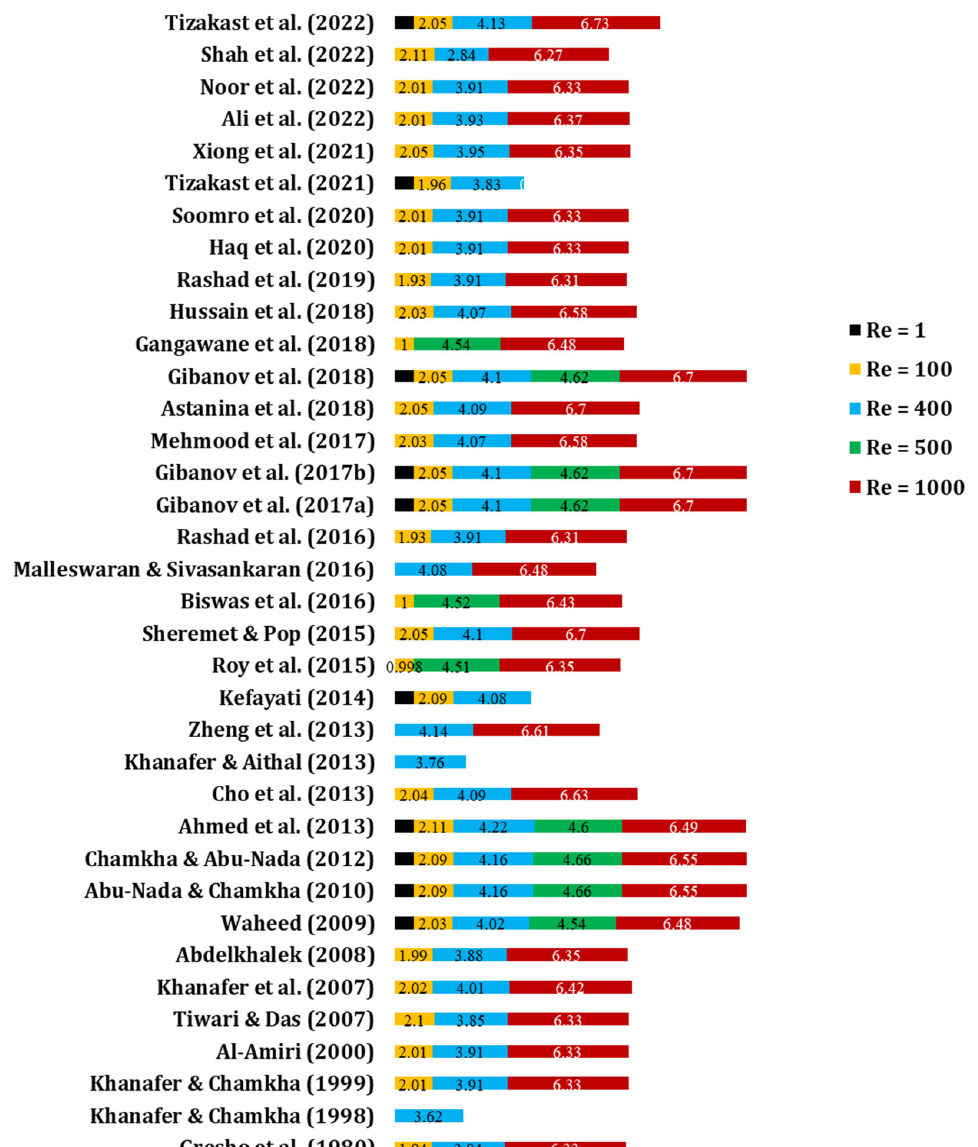
Figure 6. Variation of Nu avg with different Re for Pr = 0.71 and Gr = 10 2 (Case: Mixed convection flow in a square lid-driven cavity) [12,18,42,48,50,53,73,95,96,110,115–117,150,157,178,180,183,192,198,199, 208,268–278].